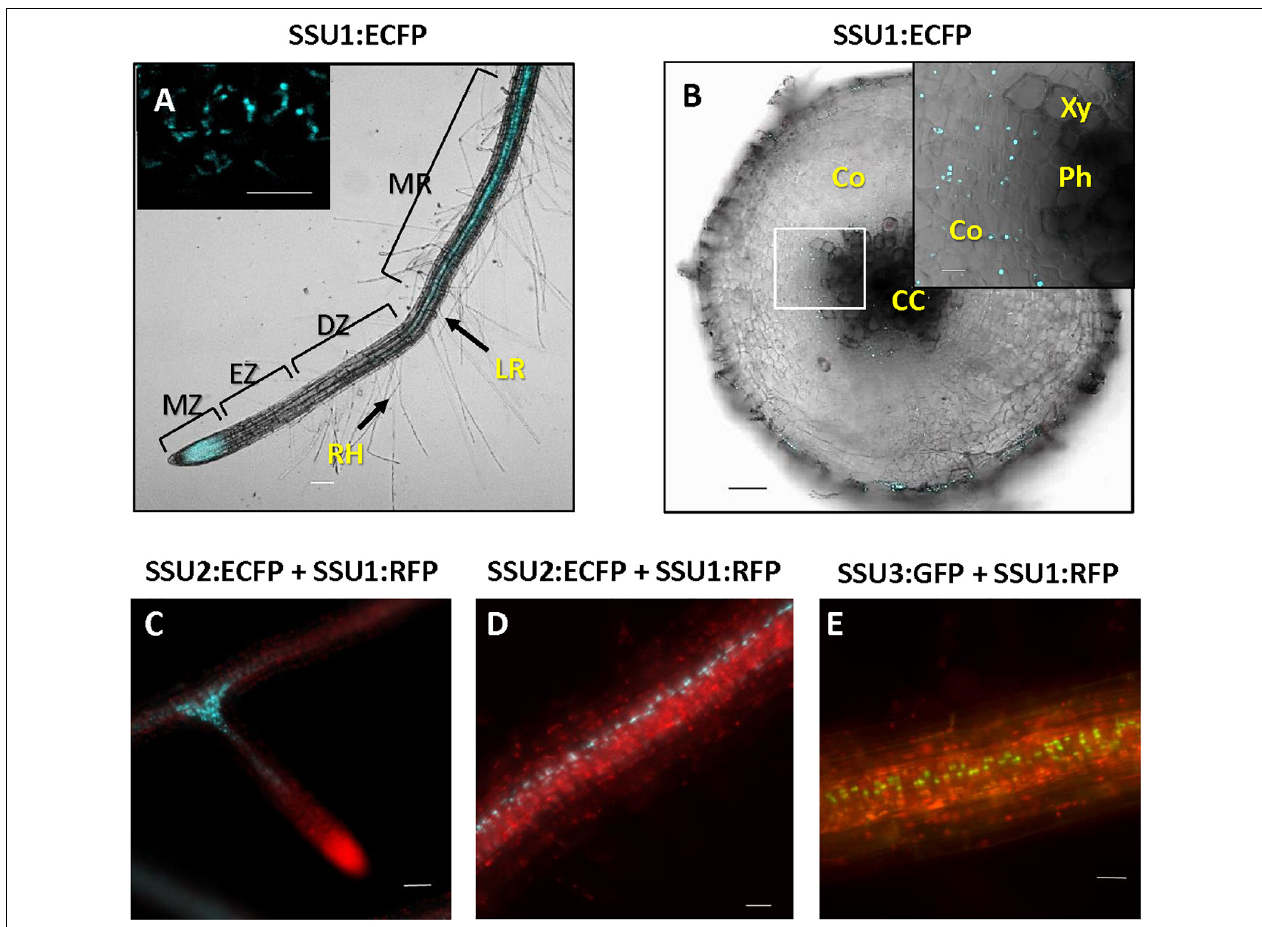
FIGURE 6 | (A) Whole mount root with IPMI SSU1:ECFP fluorescence visible in the meristematic zone (MZ) and along the stele of mature root region (MR). IPMI SSU1 is not observed in the elongation (EZ) and differentiation zones (DZ). Root hairs (RH) and an outgrowing lateral root (LR) are indicated. (B) In an older part of a mature root, IPMI SSU1 is also detectable in the cortex (Co) surrounding the central cylinder (CC) but not in the vascular tissue itself [xylem (Xy) and phloem (Ph)]. IPMI SSU1 containing plastids form stromules [inset in (A) ]. (C–E) IPMI SSU2 and IPMI SSU3 are seen in plastids along the central cylinder, with a strong accumulation of these organelles at branches (here shown for IPMI SSU2). In contrast, IPMI SSU1 is seen in plastids throughout the cortex and in the root tip (C) . Scale bars: inset in (A) 10 µ m, (B) 100 and 50 µ m, (C–E) 20 µ